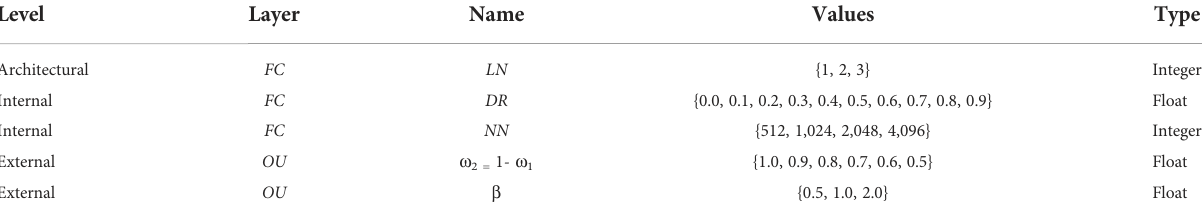
TABLE 1 Hyperparameter